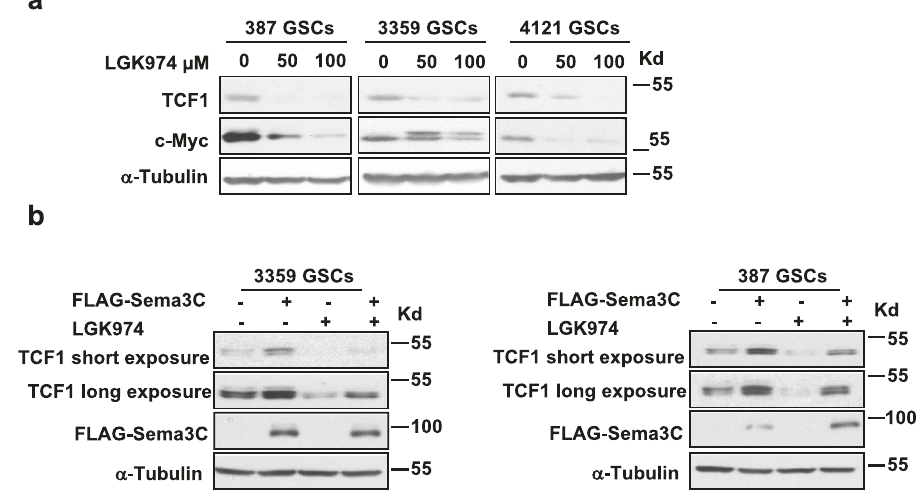
Fig.6|Sema3CconfersresistancetoWntinhibition.a WesternblotsofTCF1and c-Myc in GSCs treated with Porcupine inhibitor LGK974. Cells were treated with LGK974 or vehicle control for 24h. b Western blots of TCF1 in LGK974 treated